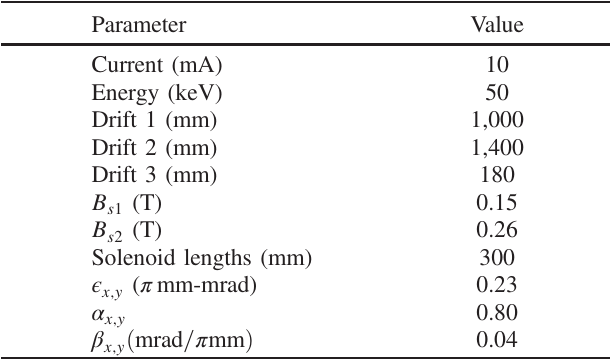
TABLE II. Final parameters of the MEHIPA LEBT and beam parameters at the